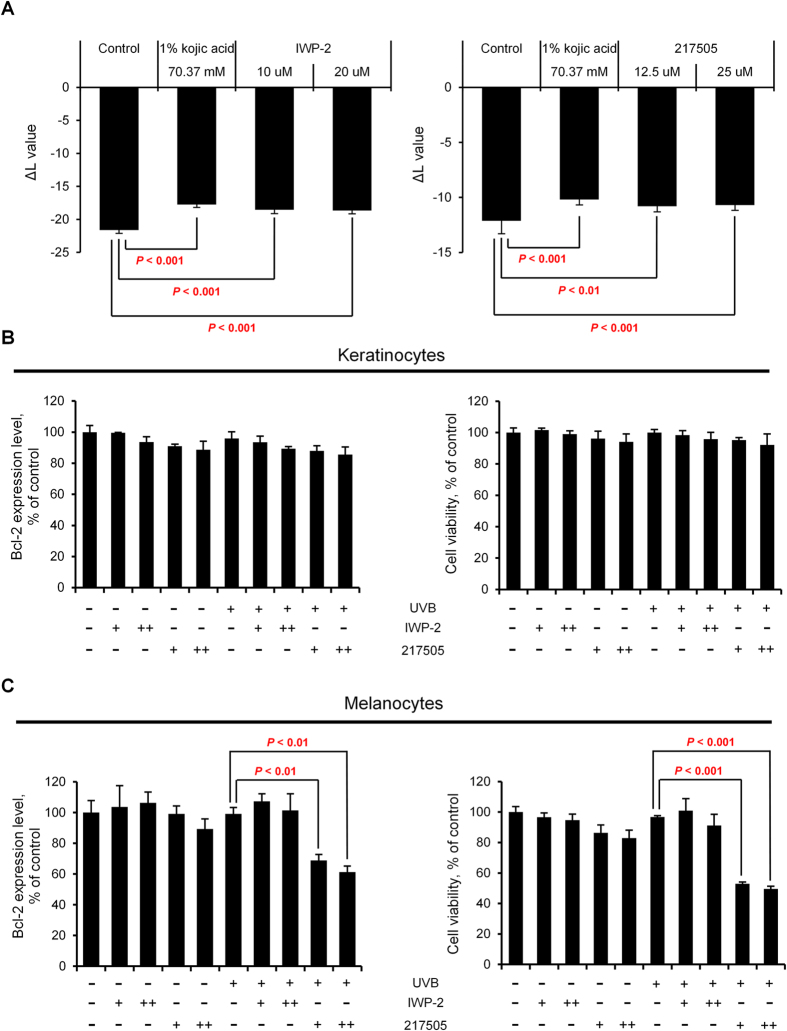
Effects of inhibition of beta-catenin or CREB on the UVB-induced skin pigmentation and Bcl-2 expression. (A) Graphs of the ΔL value of the UVB-irradiated skin equivalent model, MelanoDermsTM, exposed to the indicated concentrations of IWP-2 (an inhibitor of Wnt/beta-catenin pathway) or 217505 (a CBP-CREB interaction inhibitor). 1% kojic (70.37 mM) acid was used as a positive control. MelanoDermsTM were grown at the air-liquid interface and the maintenance medium was replenished every 2 days. After a 9-day of exposure to the chemicals, pigmentation of the skin equivalent was assessed by comparing the change in L* value, a value of CIE 1976 (L*,a*,b*) color space representing the brightness. (B and C) Graphs of the Bcl-2 expression level and the cell viability in normal human keratinocytes and normal human melanocytes exposed to IWP-2 [+, 10 μM; ++, 20 μM] or 217505 [+, 12.5 μM; ++, 25 μM] with or without UVB irradiation. Cells were cultured in 6-well plate and exposed to UVB irradiation (10 mJ/cm2). The cells were then treated with IWP-2 or 217505 for 24 hours. After incubation, the cells were harvested and lysed. Bcl-2 expression level was measured by using human Bcl-2 ELISA kit (Abcam, Cambridge, U.K.). For the cell viability assay, the cells were treated with WST-1 (Roche Molecular Biochemicals, Mannheim, Germany). Cell viability was determined from absorbance (OD 450) measured by using microplate reader. Data represent the means + SD of three biological replicates. P-values were determined by Student’s t test; P < 0.05 was considered statistically significant. No statistically significant difference in the Bcl-2 expression level or the cell viability was observed between control and IWP-2 treated cells upon UVB irradiation (P > 0.05).